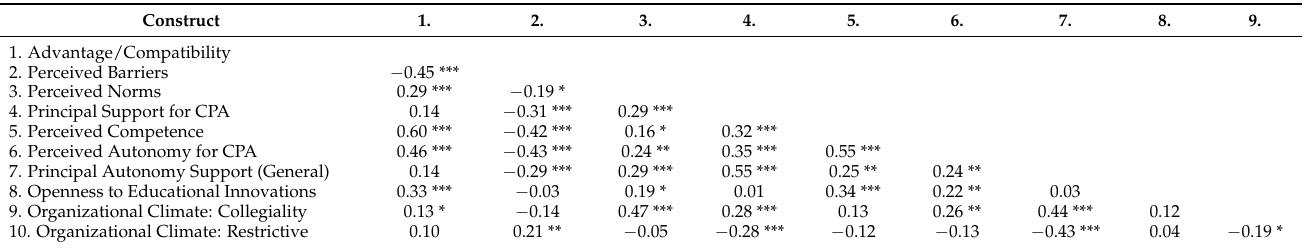
Table 4. Correlations between